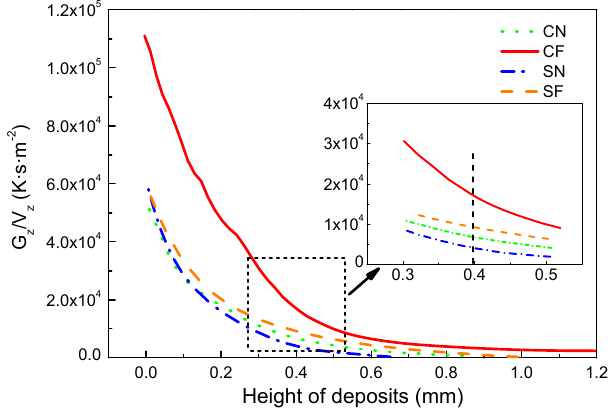
Figure 12. Variation of G z /V z with height of deposits at the solid – liquid interface in the central longitudinal section of deposits under four different conditions.